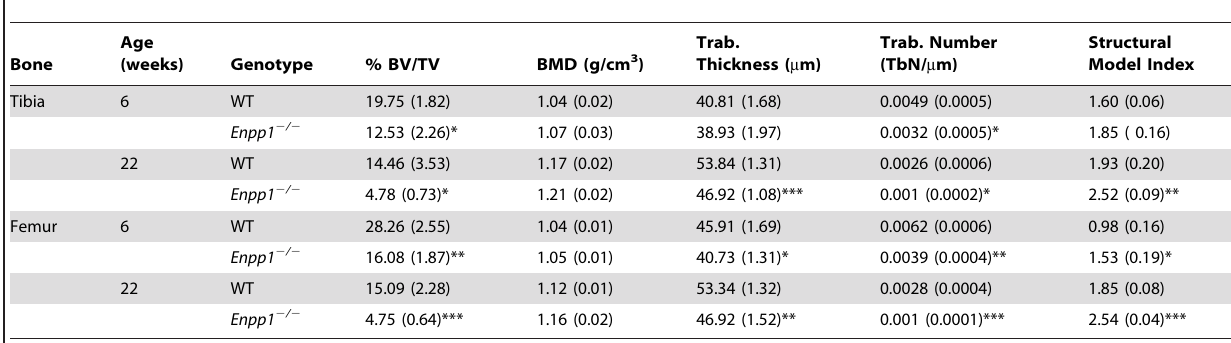
Table 2. MicroCT analysis of trabecular bone in male wild-type and Enpp1 2 / 2 mice.